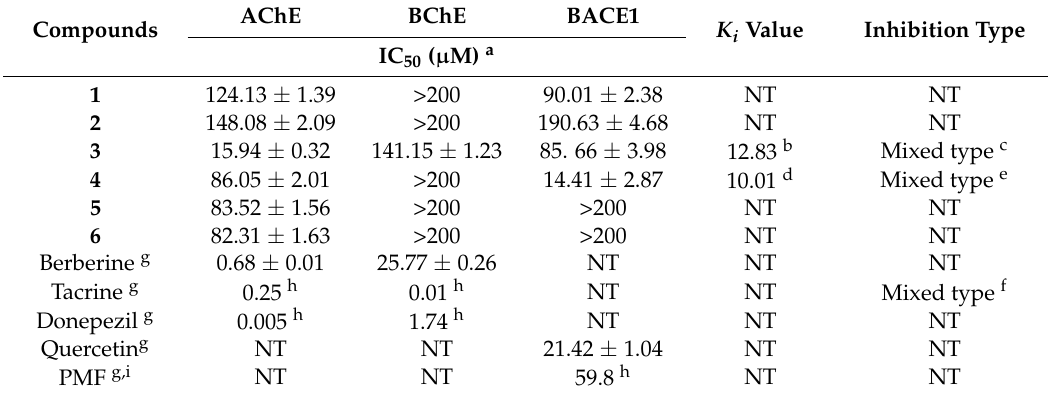
Table 1. Electric eel acetylcholinesterase, horse serum butyrylcholinesterase, and human recombinant BACE1 inhibitory activity of compounds isolated from Cassia